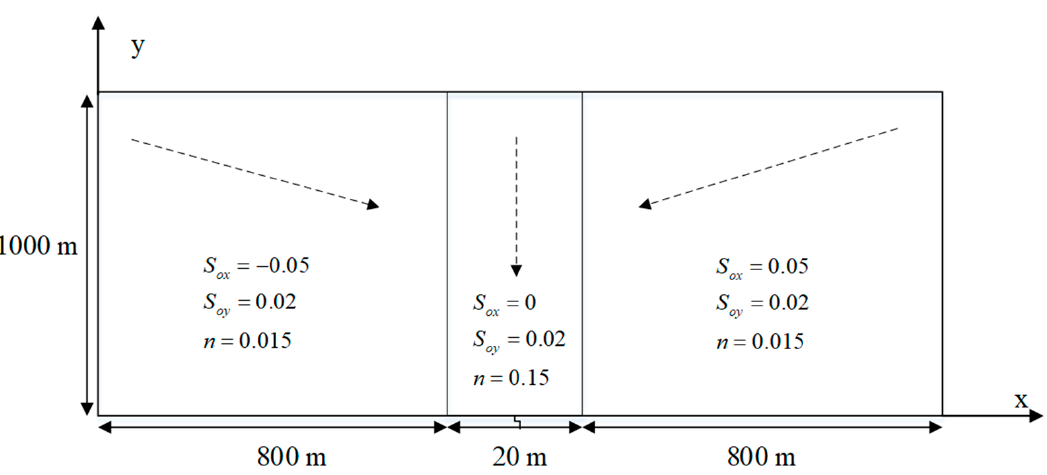
Figure 10. Detailed dimensions and related information of the V-shaped watershed.